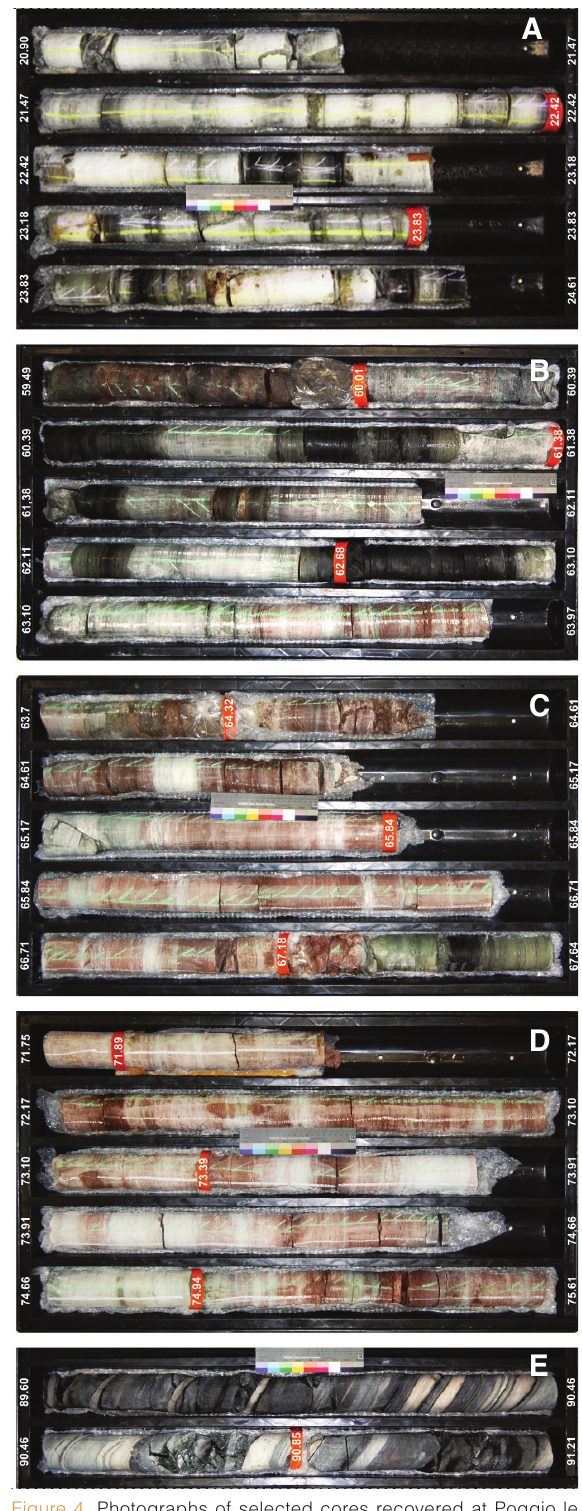
Figure 4. Photographs of selected cores recovered at Poggio le Guaine. [A] Cores 20 (20.90–22.45 m) to 22 (23.83–25.39 m) penetrated the marly limestones, marls, and black shales of the upper Albian Amadeus Segment (OAE1c); [B] Cores 46